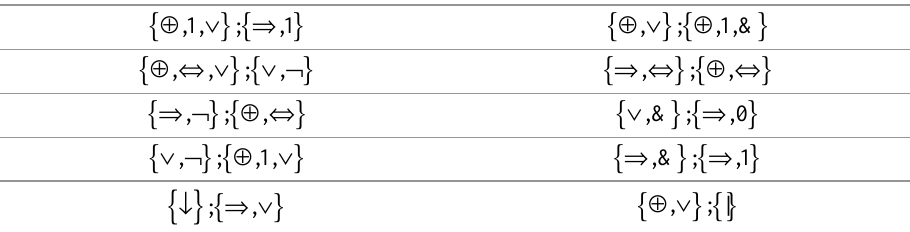
Table 2. 10 variants of discrete mathematics test item. Question: which of two Boolean functions systems is